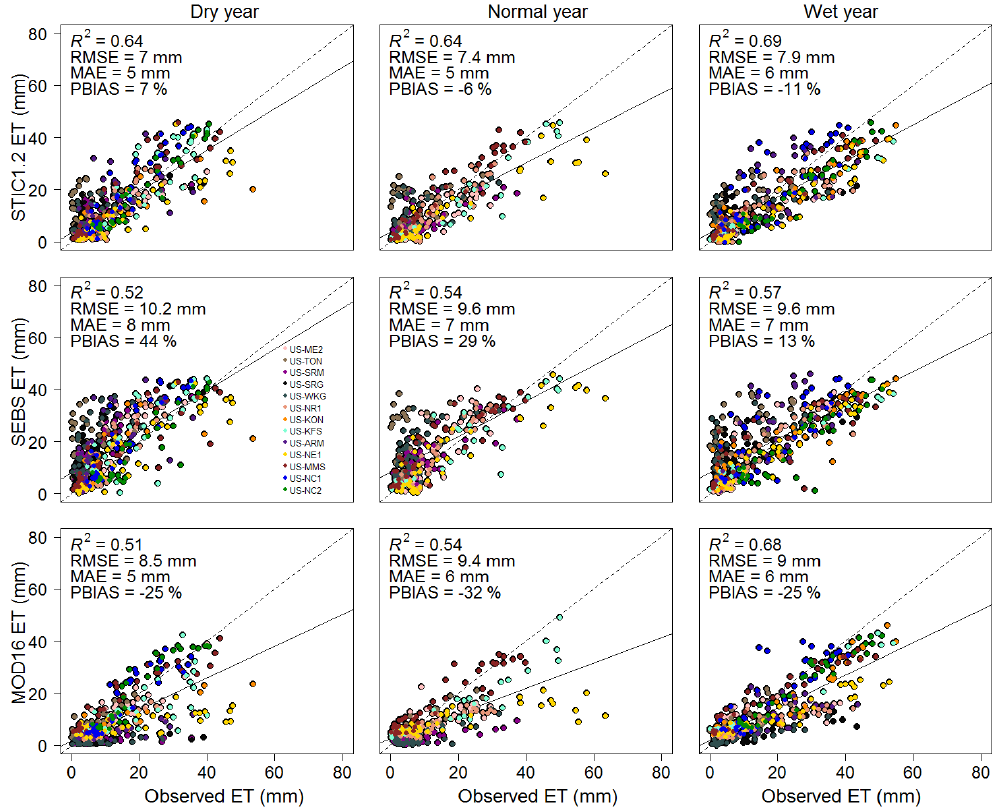
Figure 4. Evaluation of 8-day cumulative ET from STIC1.2, SEBS, and MOD16 against observed ET from 13 core AmeriFlux sites in the US during dry, wet, and normal